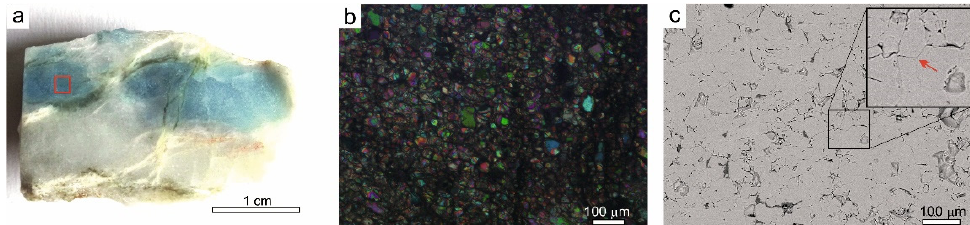
Figure 10. ( a ) Rock slice (right side of the Sissone valley) from which thin section was prepared. ( b ) Photomicrograph of the blue portion (red square in a); cross-polarized light. ( c ) BSE-SEM image of the same area. Some 120° triple junctions are visible among the grains (red arrows).